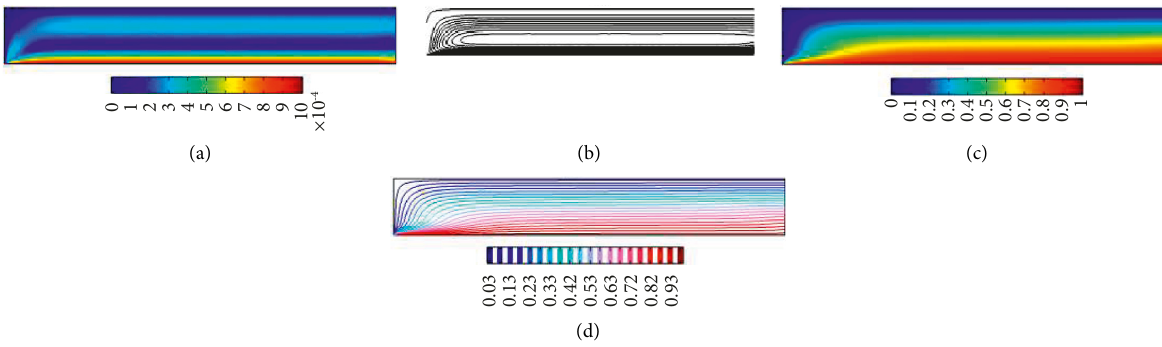
Figure 10: (a) Surface plot for velocity, (b) streamlines, (c) surface plot for temperature, and (d) isothermal contours using Gr � 100 , β � 0 . 7 , Gt � 0 , U � 0 . m w 0 1